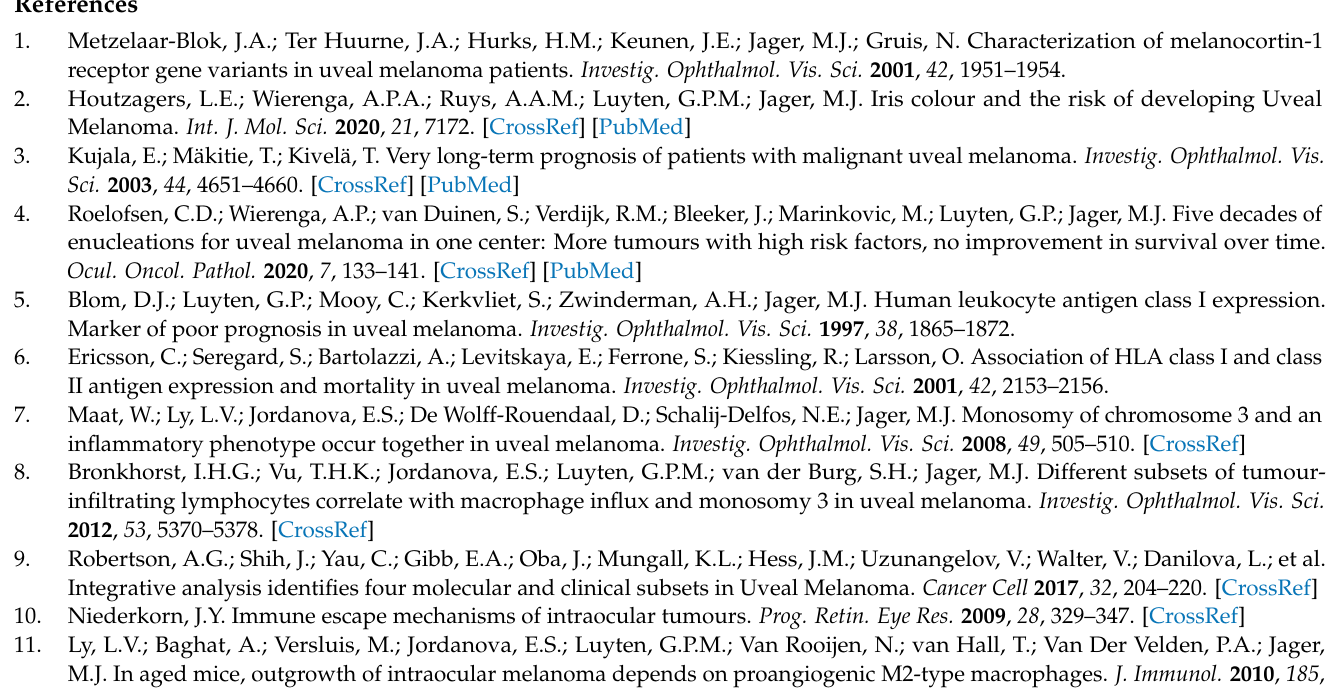
Figure S2: Survival curves for LAG3 , Galectin-3 , HLA-DRA probe 1 and HLA-DPA in the Leiden D3 tumours (all split in two groups along the median), Figure S3: Survival curves for LAG3 , Galectin-3 , HLA-DRA probe1 and HLA-DPA in the Leiden M3 tumours (all split in two groups along the median), Table S1: Correlation between mRNA expression levels (determined by Illumina array) of LSECtin , Galectin-3 , HLA Class II genes and infiltrate markers versus expression of LAG3 in: A. the Leiden cohort ( n = 64), and B. the TCGA cohort ( n = 80). R = two-tailed Spearman correlation